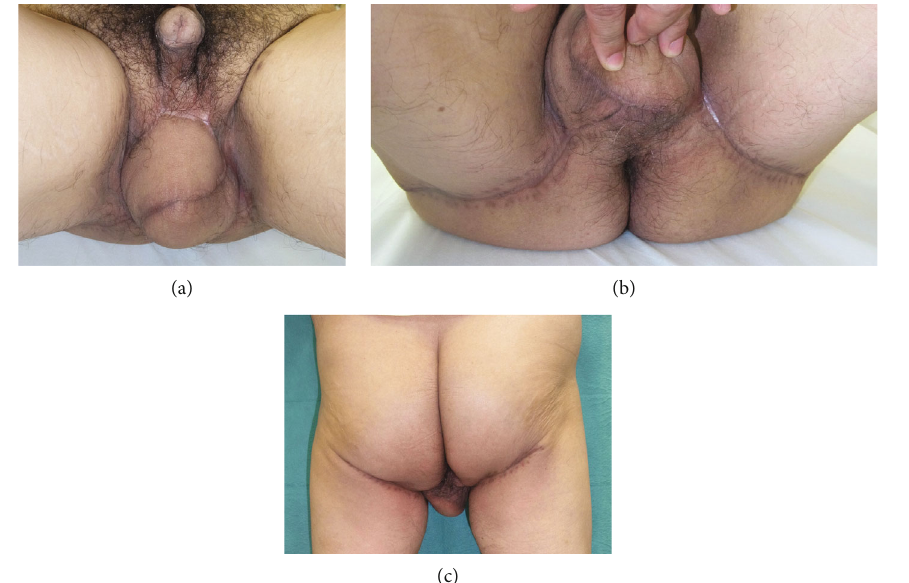
Figure 3: Case 1, eight months after reconstruction surgery. (a) Anterior view of the scrotum. (b) Posterior view of the scrotum. (c) Standing view.